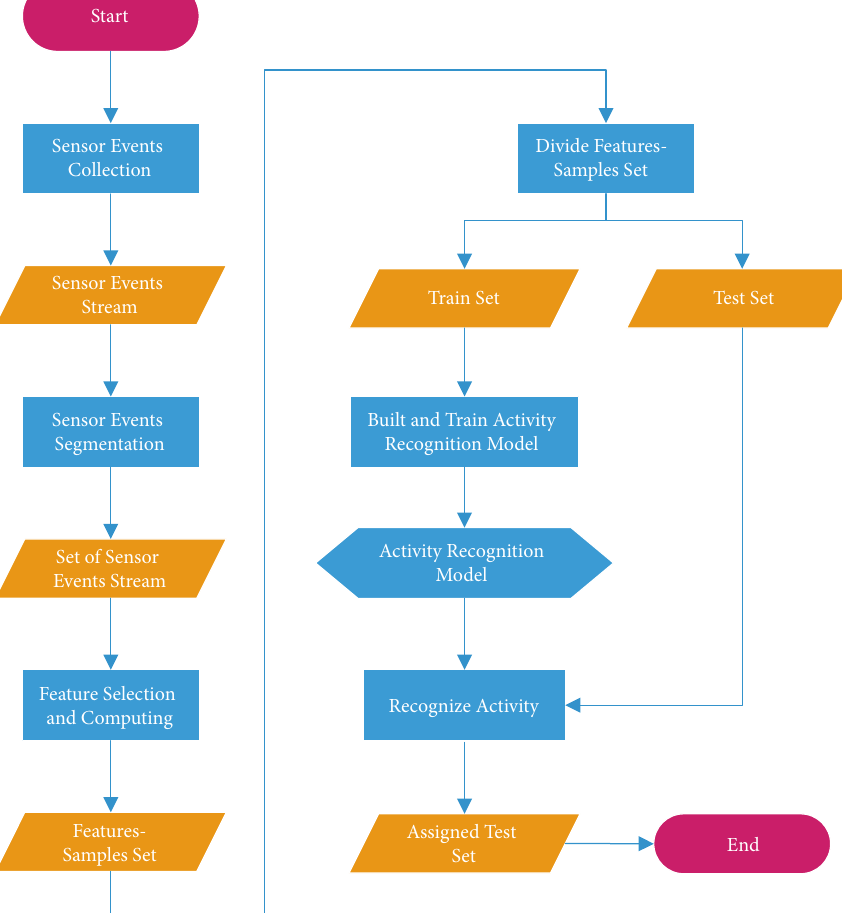
Figure 1: Process of activity